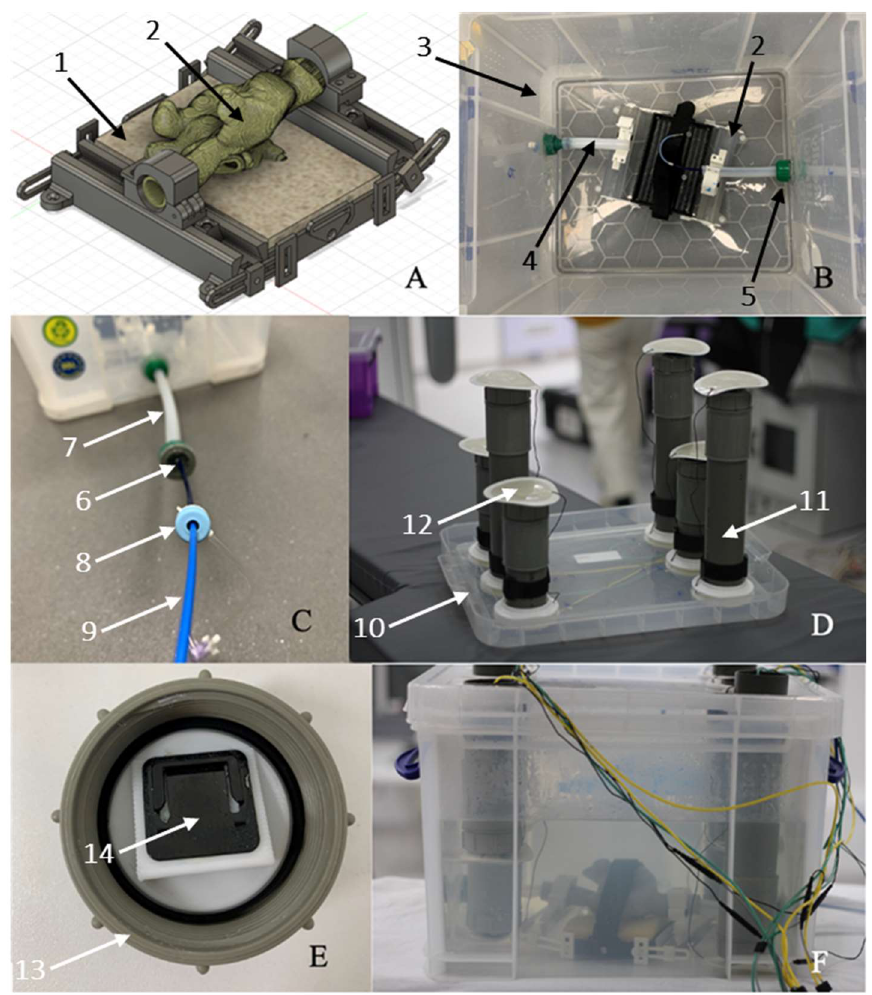
Figure 8. ( A ) Fusion360 model of simulator base (1) with inserted bi-atrial model (2). ( B ) Simulator base inside the Really Useful Box (3) with connecting silicone tubing (4) leading to standard hose connectors (5) with silicone plugs (6) to act as hemostatic valves. ( C ) Silicone tubing extension (7) to IVC entry point showing insertion of a sheath (8) and ablation catheter (9). ( D ) lid assembly (10) with PVC tubes (11) to accommodate the CARTO3 patches (12). ( E ) PVC tube end cap (13) with CARTO3 patch connector (14). ( F ) Complete simulator assembly with wiring to CARTO3 system and RF generator.